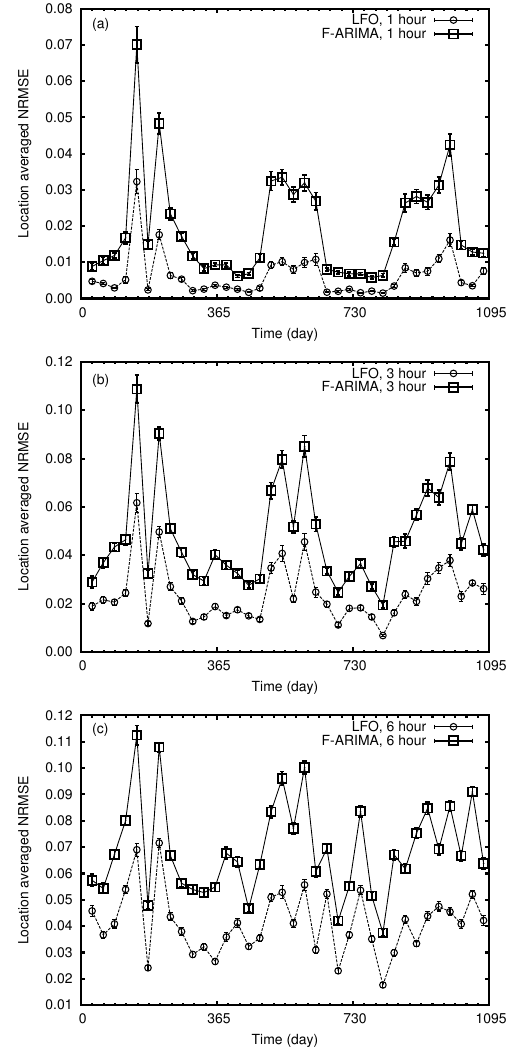
Figure 14. Location-averaged NRMSE, with standard error, of Fig. 14. Location averaged NRMSE, with standard error, of (a) 1 hour, (b) 3 hour and (c) 6 hour predictions for the period of 3 years (a) 1h, (b) 3h and (c) 6h predictions for the period of 3 years from from 2004 over 234 locations using LFO and f-ARIMA. 2004 over 234 locations using LFO and